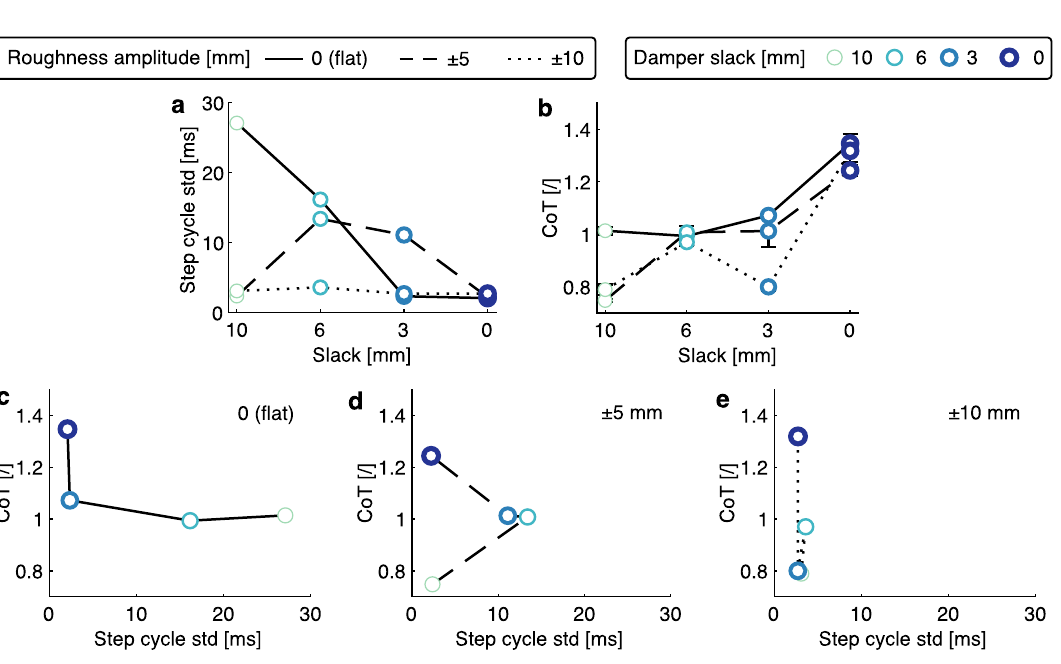
Figure 3. Forward hopping with continuous perturbation: ( a ) The standard deviation of the step cycle time shows that the hopping periodicity is improved with higher damping (less slack). ( b ) The relationship between the CoT and the damper slack settings. ( c ) In flat terrain, the robot’s ability to maintain periodic hopping is improved by higher damping at the cost of CoT. ( d,e ) In the continuous perturbation terrain, high damping is also associated with high CoT and good